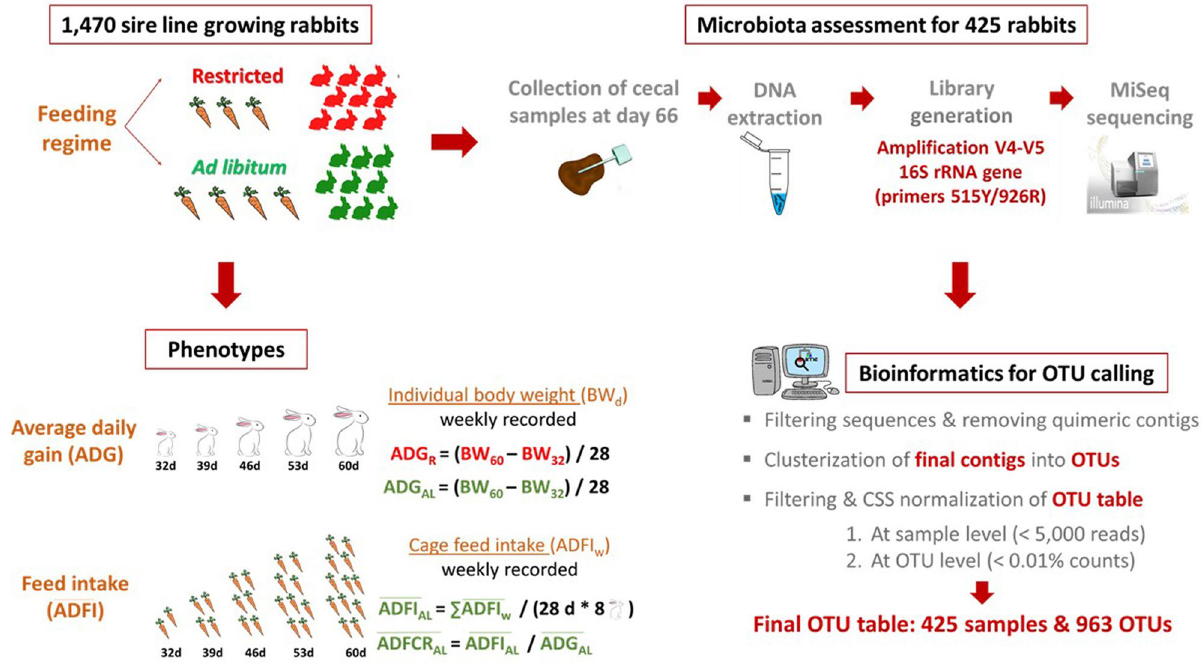
Figure 2. Graphical summary of the experimental design, phenotypes analyzed, microbiota assessment of cecal samples and bioinformatic pipeline for OTU